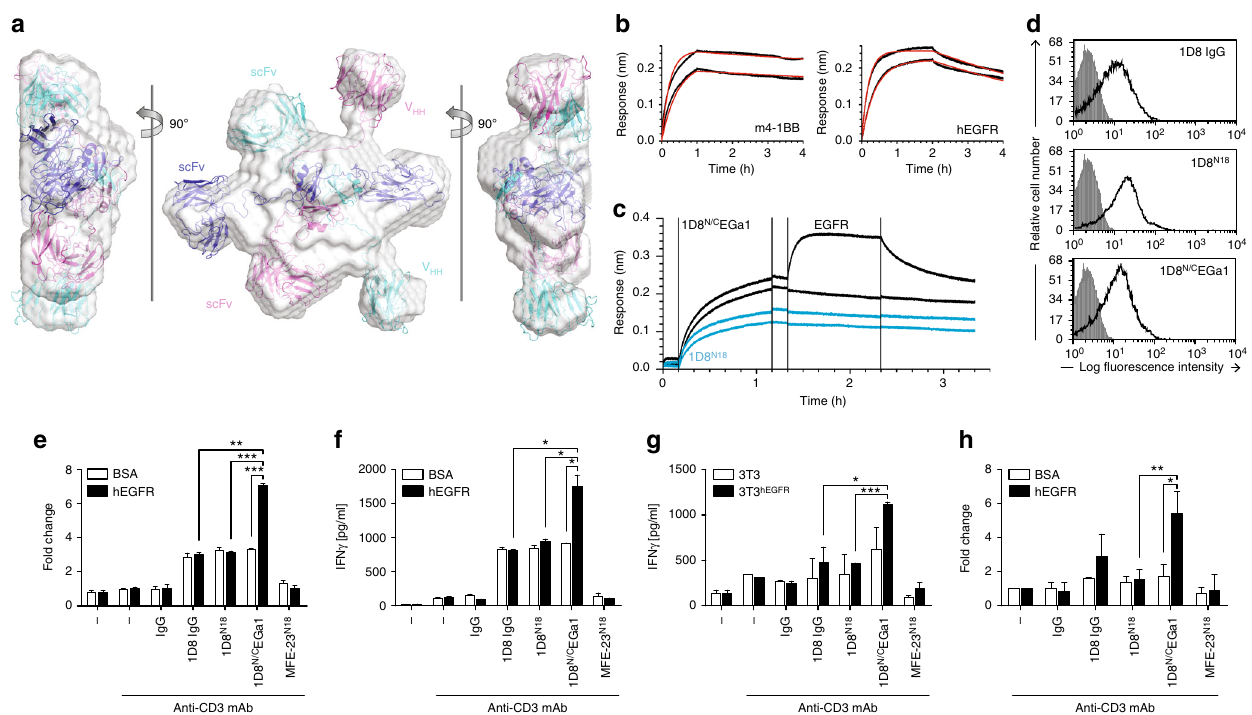
Fig. 3 Characterization of the EGFR-targeted 4-1BB-agonistic trimerbody. a Arrangement of 1D8 N/C EGa1 trimerbody in solution by SAXS. Rigid-body fi tting of the model corresponding to 1D8 NC EGa1 inside the SAXS envelope (colored in pale gray). Each chain has been colored in blue, magenta, or cyan. b Sensorgrams (black curves) and the results of fi tting to a 1:1 model (red curves) obtained using biolayer interferometry for the interaction of 1D8 N/C EGa1 (2 and 4 nM) with immobilized m4-1BB and the interaction of 1D8 N/C EGa1 (0.5 and 1 nM) with immobilized hEGFR. c Simultaneous binding to both m4- 1BB and hEGFR was demonstrated for 1D8 N/C EGa1 but not 1D8 N18 . Biosensors were coated with m4-1BB, after which 4 nM of 1D8 N/C EGa1 (black curves) or 1D8 N18 (blue curves) were added. d The binding of anti-4-1BB antibodies to m4-1BB on the cell surface of stimulated mouse CD8a + T cells measured by FACS. e , – f Mouse CD8a + T cells were plated with immobilized anti-CD3 mAb and hEGFR or BSA in the presence of 1D8 N18 , 1D8 N/C EGa1, or 1D8 IgG, and proliferation ( e ) and IFN- γ secretion ( f ) were determined after 48 h. EGFR-negative 3T3 cells or EGFR-positive 3T3 hEGFR cells were co-cultured with mouse CD8a + T cells in the presence of anti-CD3 mAb and 1D8 N18 , 1D8 N/C EGa1, or 1D8 IgG. IFN- γ secretion analyzed after 48 h ( g ) and cell viability after 72 h ( h ). Data are represented as fold change relative to the values obtained from anti-CD3 mAb stimulated cells. Rat IgG 2a and MFE-23 N18 were used as negative controls. Data are mean ± SD ( n = 3), * P ≤ 0.05, ** P ≤ 0.01, *** P ≤ 0.001, Student's t